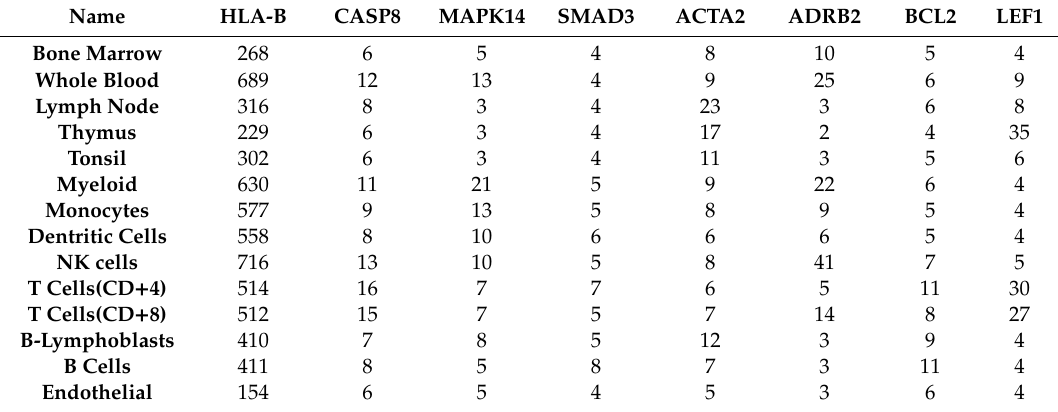
Figure 6. Target size and color settings were used to reflect Degree value size. The larger the shape and the darker the color of the node indicates that the target (gene) could play a role in the more immune tissues and cells. Table 7. Expression of 8 LC treatment targets in 14 immune tissues and cells.